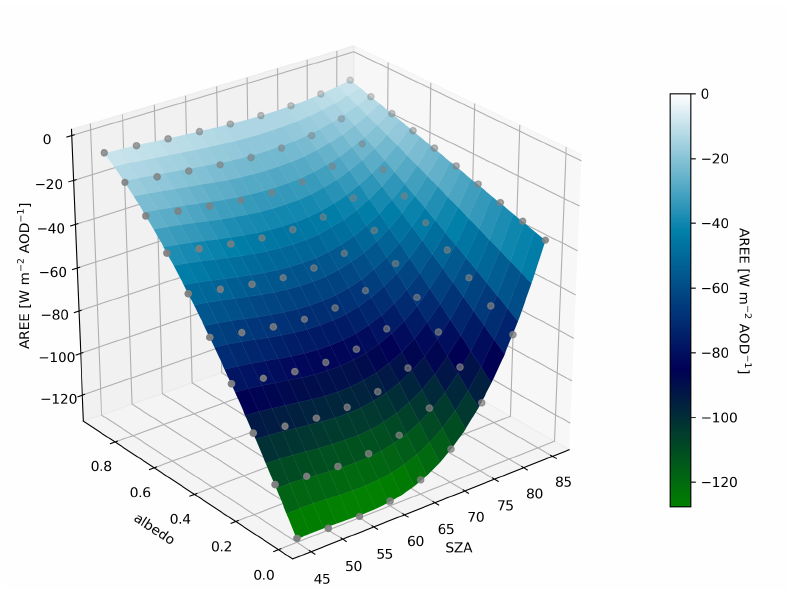
Figure 4. AREE as a function of SZA and surface albedo. See Section 3.3 for further details. The AREE values for snow-covered surfaces (albedo ∼ 0.8) varies between − 11 and − 22 Wm − 2 AOD − 1 , while for sea ice (albedo ∼ 0.4), the AREE is − 63 Wm − 2 AOD − 1 for SZA = 45 ◦ , − 70 Wm − 2 for SZA = 60 ◦ , and then decreases rapidly for larger SZAs.